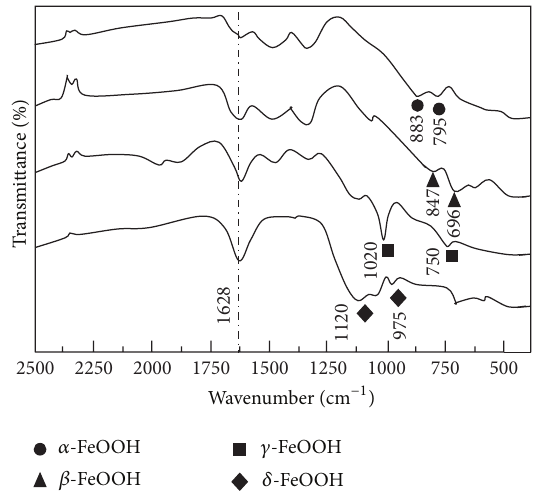
Figure 2: FTIR spectra of different forms of FeOOH. e : 𝛼 -FeOOH; 󳵳 : 𝛽 -FeOOH; ◼ : 𝛾 -FeOOH; X : 𝛿